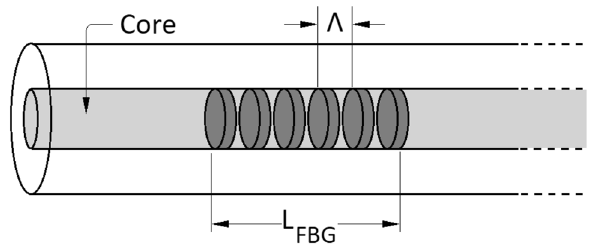
Fig. 1 Structure of a fibre Bragg grating (FBG) sensor. L FBG is the sensor length and 𝛬 is the grating